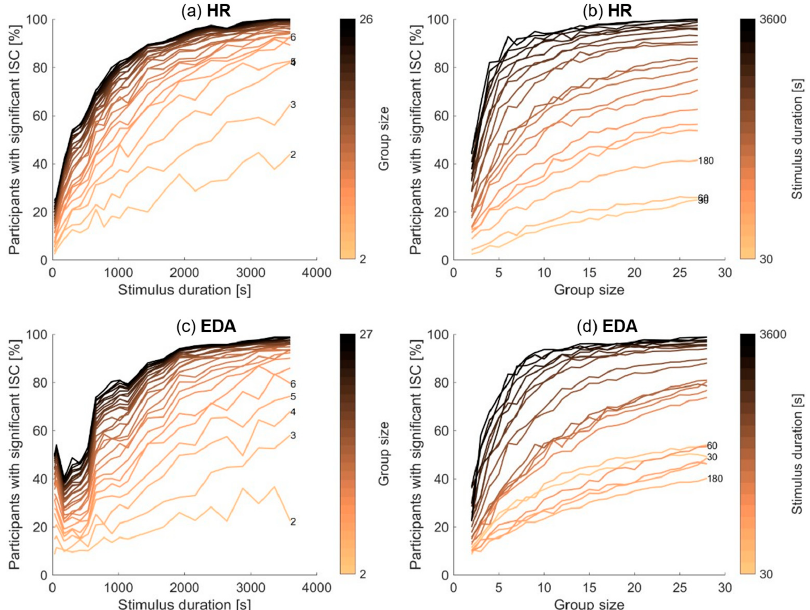
Figure 2. Percentage of participants with significant inter ‐ subject correlations for HR ( top ; a , b ) and EDA ( bottom ; c , d ) as a function of stimulus duration ( left ; a , c ) and participant group size ( right ; b , d ), averaged over the six movie orders and 50 subsets of participant combinations. The color of the lines refers to the group size in the left plots and to the stimulus duration in the right plots, as do the numbers on the right side of some of the lines.